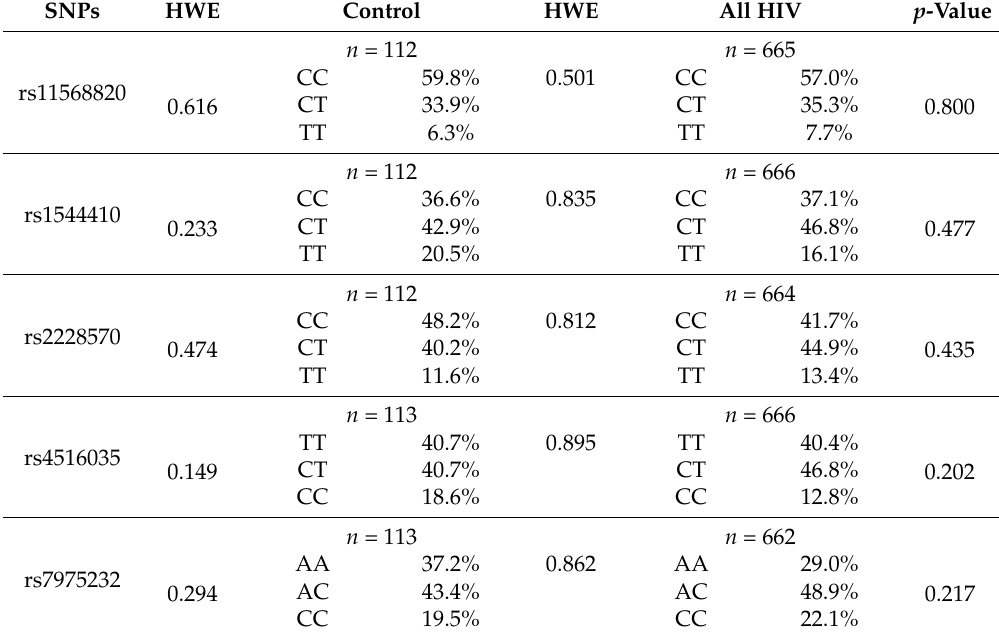
Table 2. Characteristics of vitamin D receptor ( VDR) polymorphisms in HIV infected patients and healthy